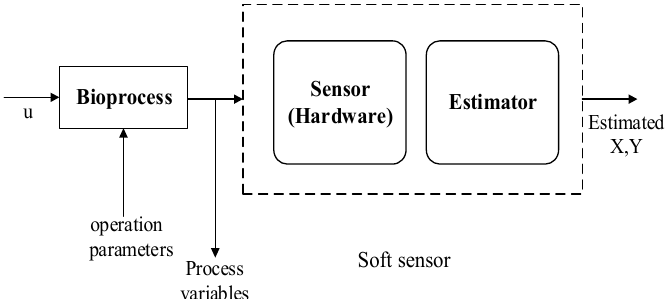
Figure 1. The concept of a soft sensor as presented in [10]. This figure describes the model of a soft sensor with one hardware sensor and an estimator. Input from a bioprocess is measured through the sensor (in reality this can be a combination of several hardware sensors) and new information is estimated.